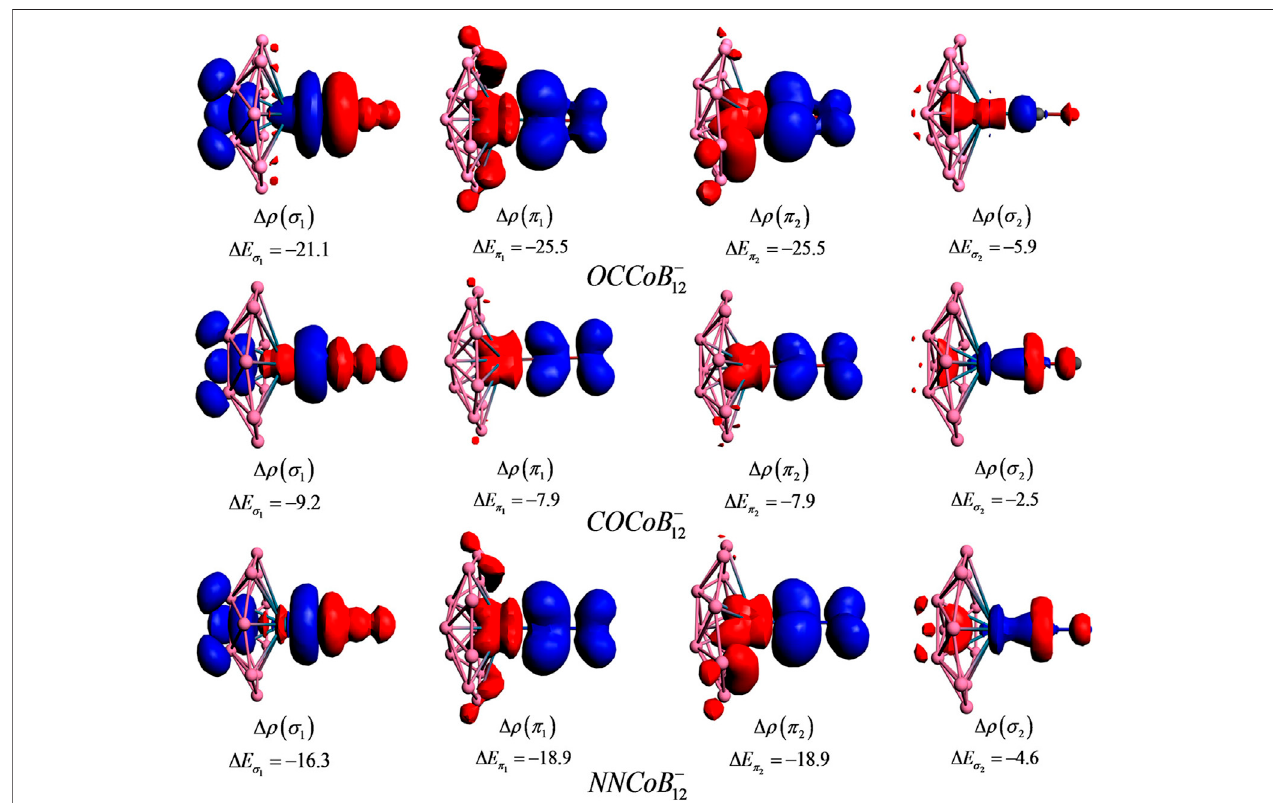
FIGURE11| Deformationdensity plotsofthepairwiseorbitalinteractions inLCoB 12- (OC,CO,andNN)systemsattherevPBED3/TZ2P//PBE/def2-TZVPPD level. Energies are provided in kcal/mol. (Reprinted with permission from Saha et al., 2017. Copyright© 2017, American Chemical Society.).